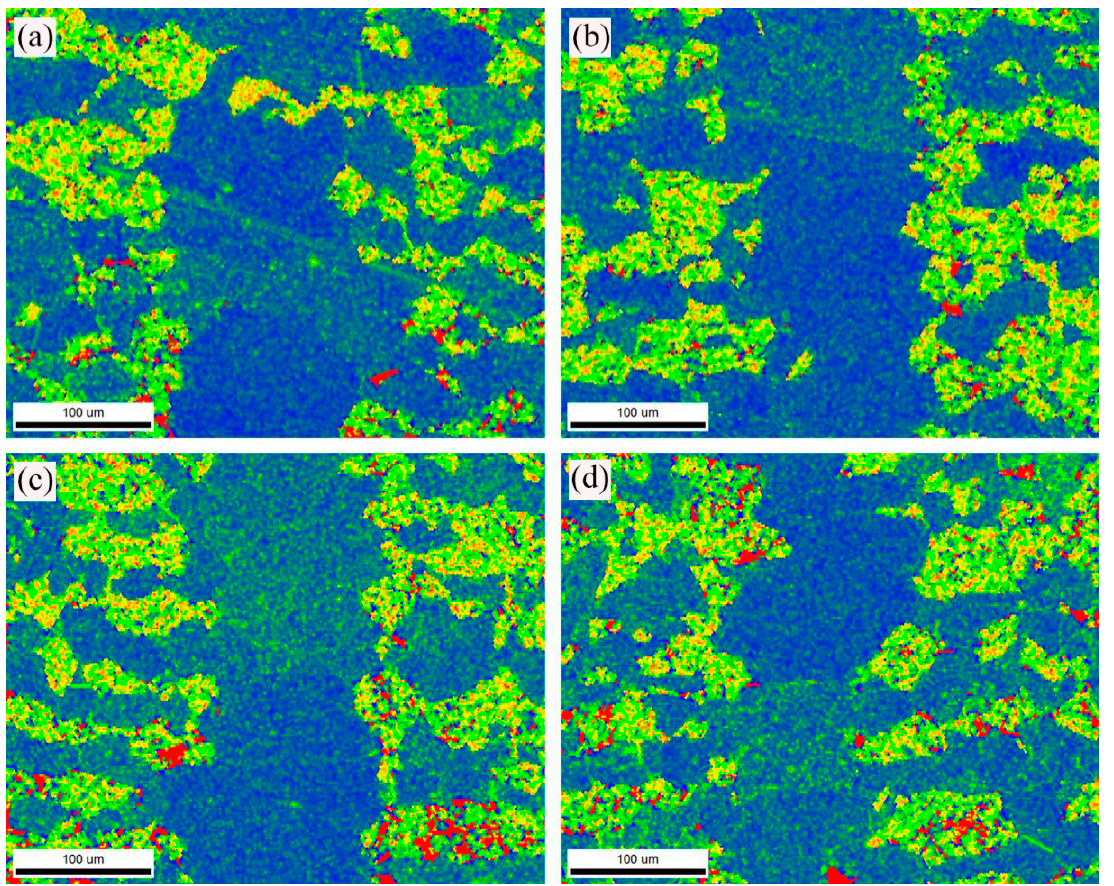
Figure 13. KAM maps of the joint regions for different aging times: ( a ) 5 h, ( b ) 20 h, ( c ) 100 h, and ( d ) 500 h.